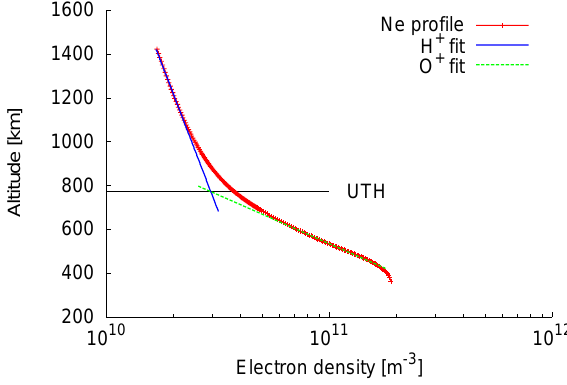
Fig. 2. The upper transition height determined by fitting the O + regression line at the bottom part and the H + regression line at the top part of the N e profile on a logarithmic (ln( N e ))